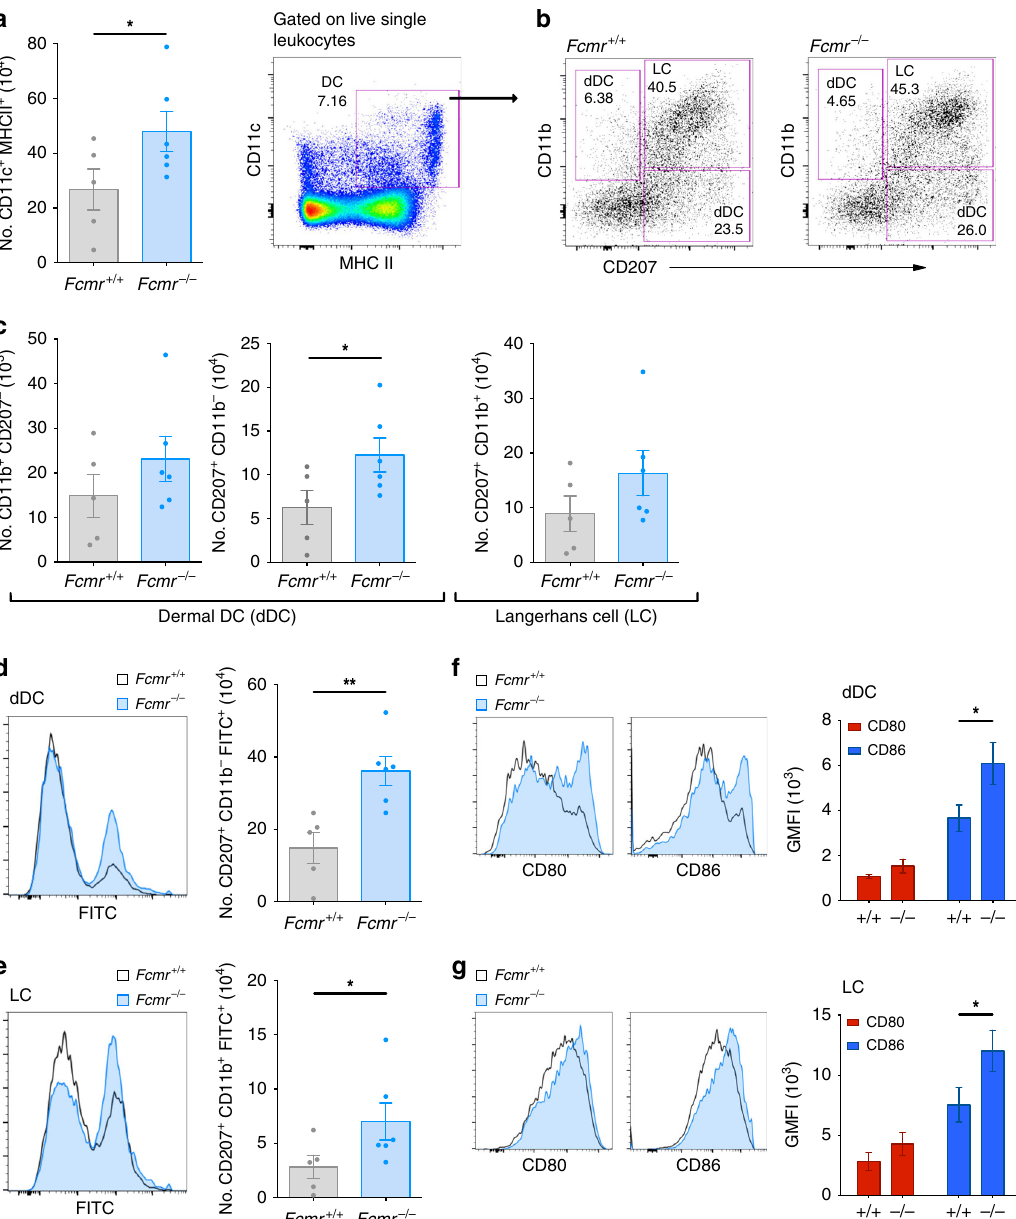
Fig. 3 Fcmr inhibits skin DC migration, phagocytosis, and maturation. a Left: Quanti fi cation of total inguinal LN DCs in Fcmr + / + and Fcmr − / − mice at 24 h after ventral skin painting with FITC-dibutylthalate. Right: Representative fl ow cytometry plot showing the gating strategy. Data are representative of n = 5 Fcmr + / + and 6 Fcmr − / − mice. b Representative fl ow cytometry plots illustrating the gating strategy to identify the CD11b + and CD11b − subpopulations of dermal DCs (dDC) as well as Langerhans cells (LC) within the total DC population in the inguinal LN of the Fcmr + / + and Fcmr − / − mice painted with FITC- dibutylthalate in ( a ). c Quanti fi cation of the fl ow cytometry data collected on the two dermal DC and LC populations in ( b ). Each data point represents an individual mouse ( n = 5 Fcmr + / + and 6 Fcmr − / − mice). d , e Left: Representative histograms showing FITC-negative and -positive subsets of the d dDC and e LC populations in the inguinal LN of the Fcmr + / + and Fcmr − / − mice in ( a – c ). Right: Quanti fi cation of the number of FITC-positive d dDC and e LC in the left panels. f , g Left: Representative histograms depicting cell surface levels of CD80 and CD86 on f dDC and g LC in the inguinal LN of the Fcmr + / + and Fcmr − / − mice in ( a – e ). Right: GMFI quanti fi cation of CD80 and CD86 expression levels on the f dDC and g LC in the left panel. Data are represented as mean ± SEM ( t test; * p < 0.05; ** p < 0.01; *** p <